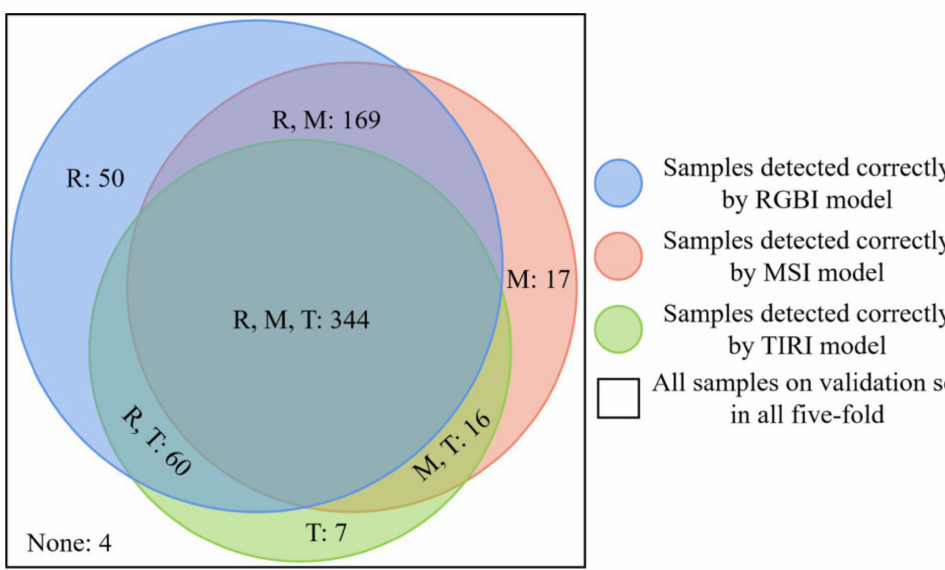
Figure 7. The number of samples correctly detected by RGBI, MSI, and TIRI models on the validation set in all five-fold. Numbers mean the number of correctly detected samples. “R”, “M”, and “T” rep- resent RGBI, MSI, and TIRI models. The letters before the numbers represent the number of samples that can be correctly detected by which models. “None” means that no model detects